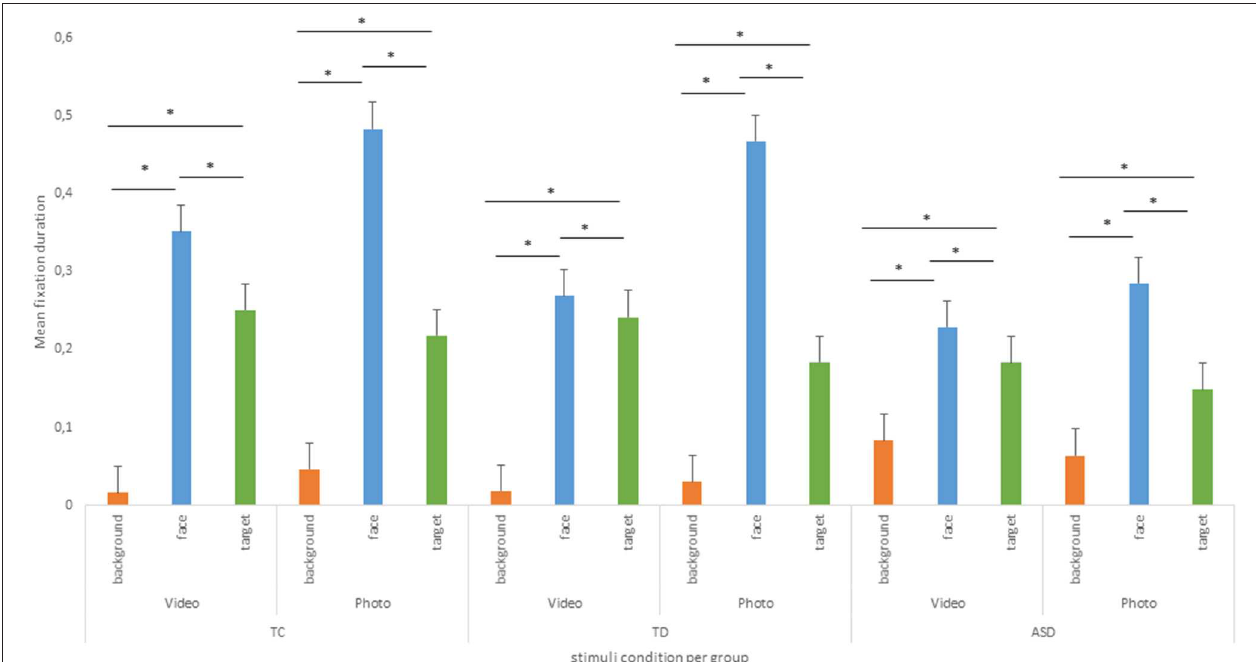
FIGURE 3 | Mean of relative fixation duration by group and AOI. * p <